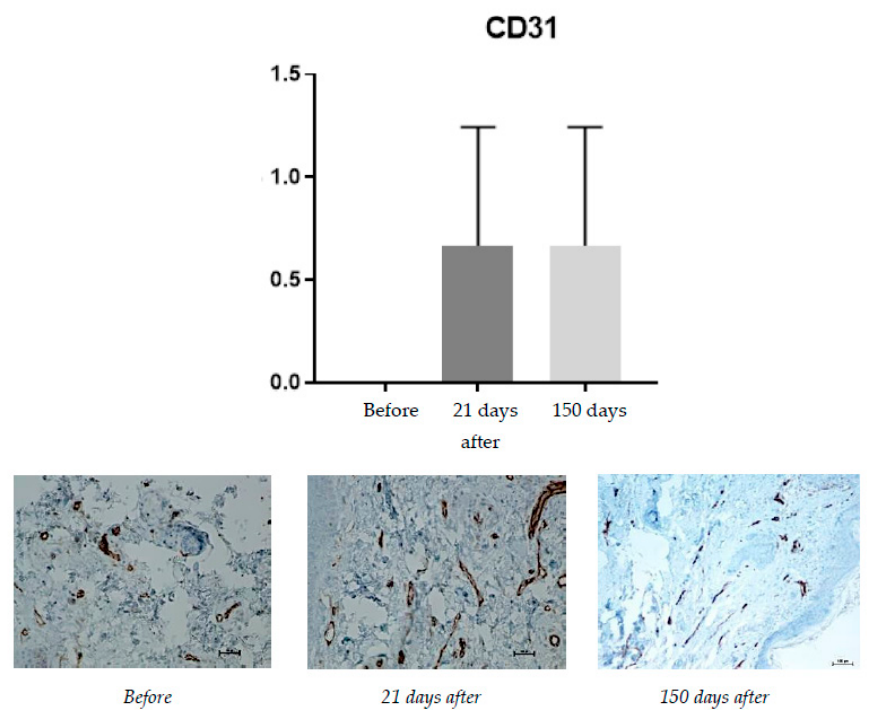
Figure 5. Increase in CD31 expression, from left to right: before treatment; 21 days after treatment; 150 days after treatment.